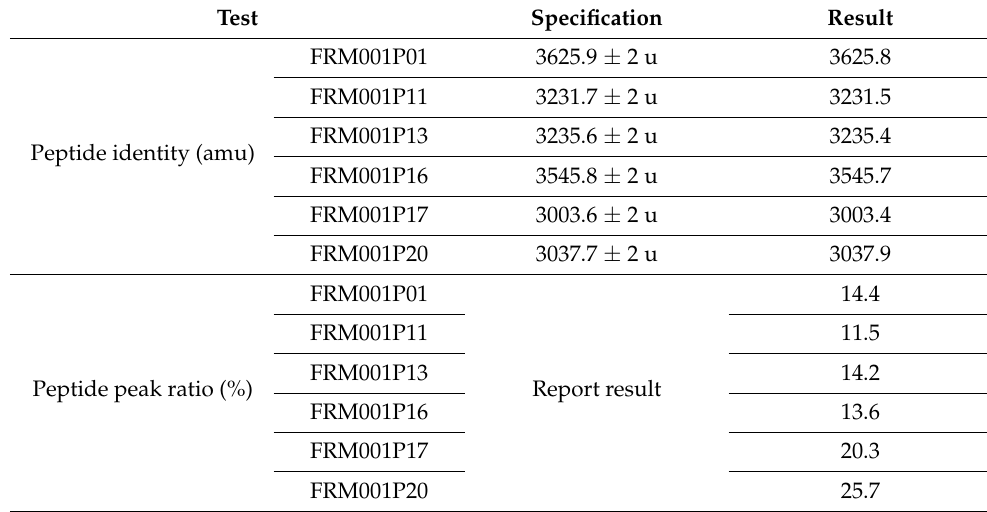
Table 7. The tests results of peptide mixture FRM001-M4 that was manufactured under GMP